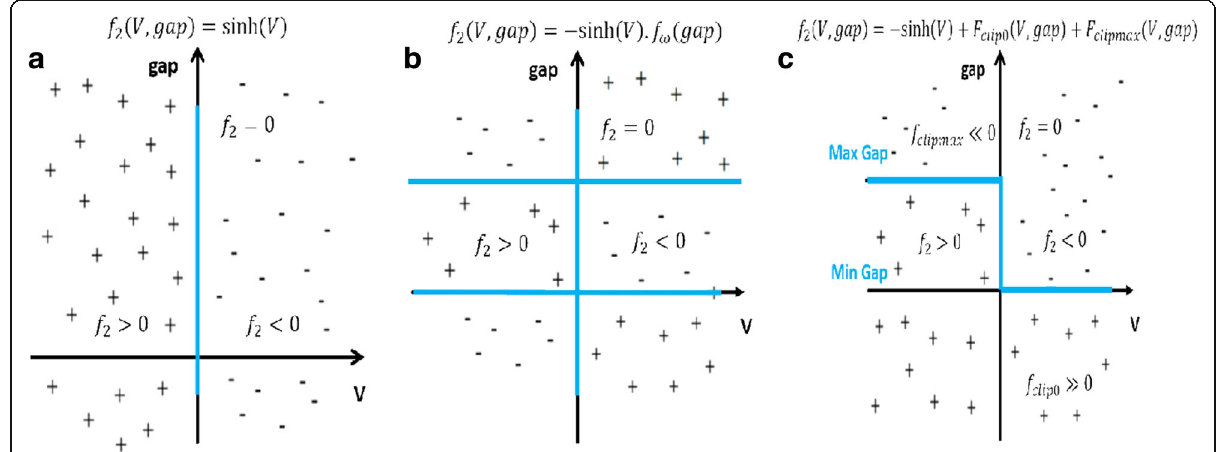
Fig. 24 Different choices of f 2 considered in the RRAM model